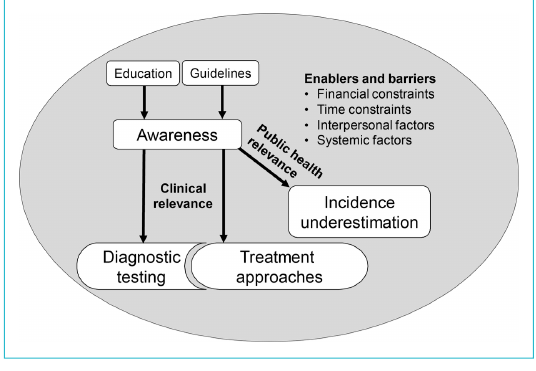
Figure 1: Overview of the themes and their relationships with each other which emerged from the in-depth interviews with 46 Swiss physicians on pneumonia and Legionnaires’ disease.